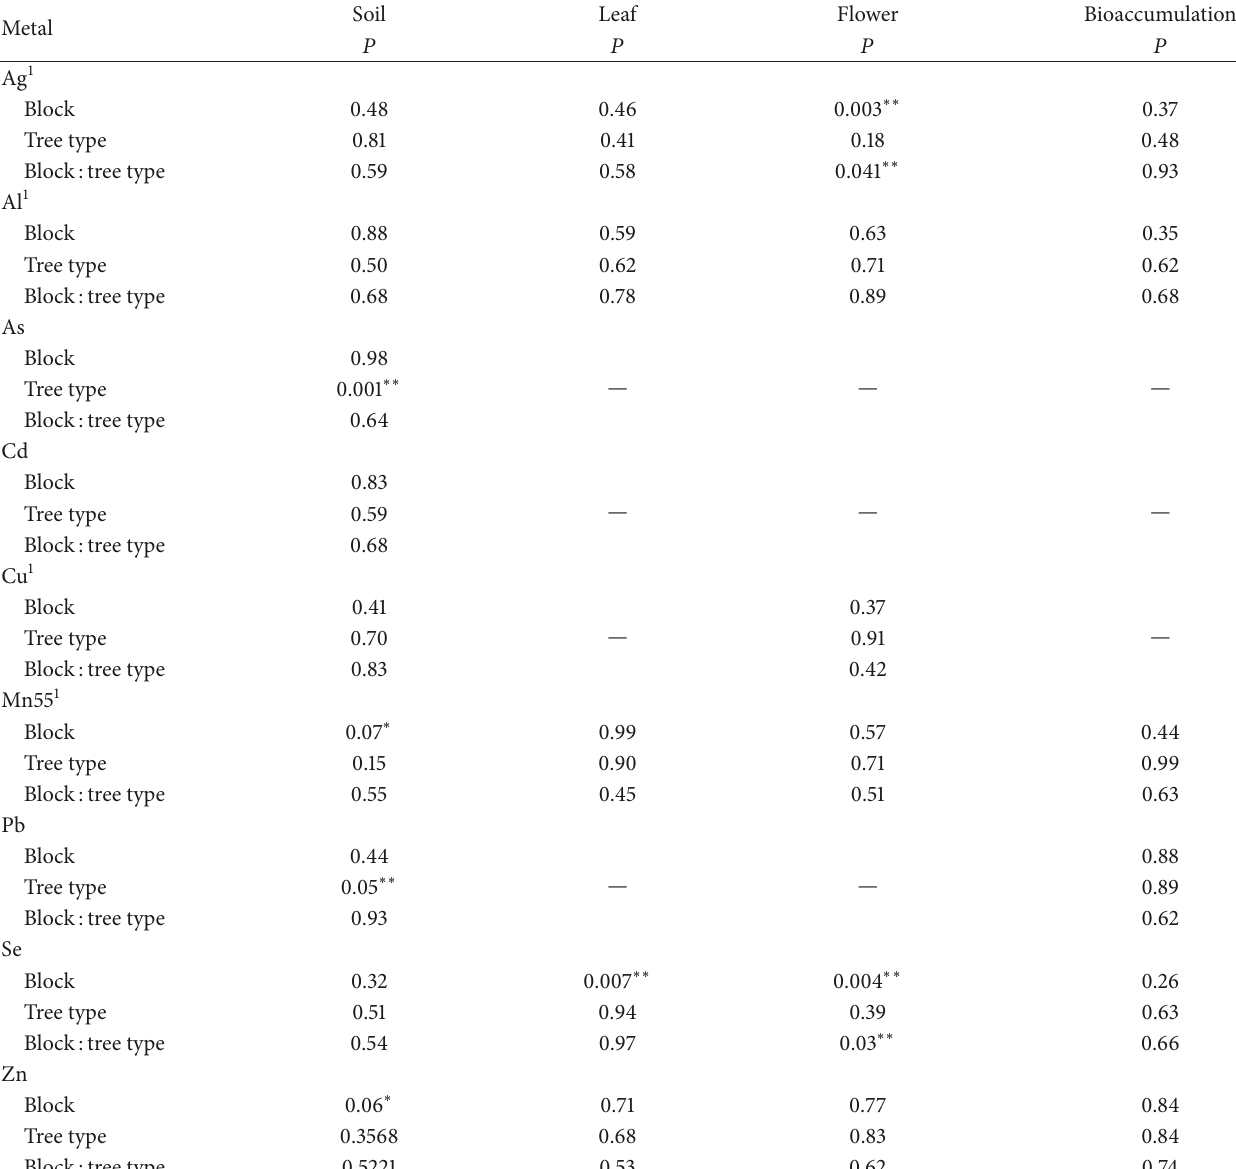
Table 5: Two-way analysis of variance results for soil, leaf, flower, and bioaccumulation of each metal concentration by block and tree type at Tri-Valley Wildlife Management Area, Dresden, OH. Response variables were block and tree type (pure American, BC 1 F 3 , and BC 2 F 3 ). Superscripts indicate required data transformations to achieve residual normality. Dashes (—) indicate levels that were an insufficient sample size for analysis due to concentration levels below detection limit. Asterisks ( ∗∗ ) indicate differences at 0.05 with single asterisk ( ∗ ) noting marginal